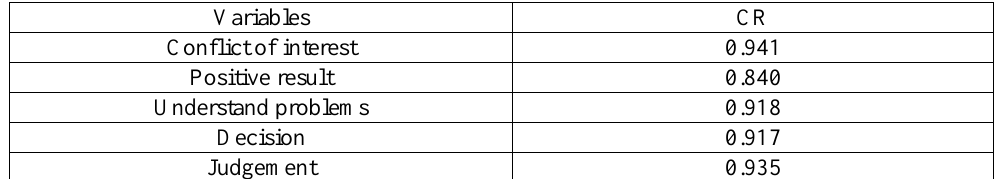
Table 3. Composite reliability of research